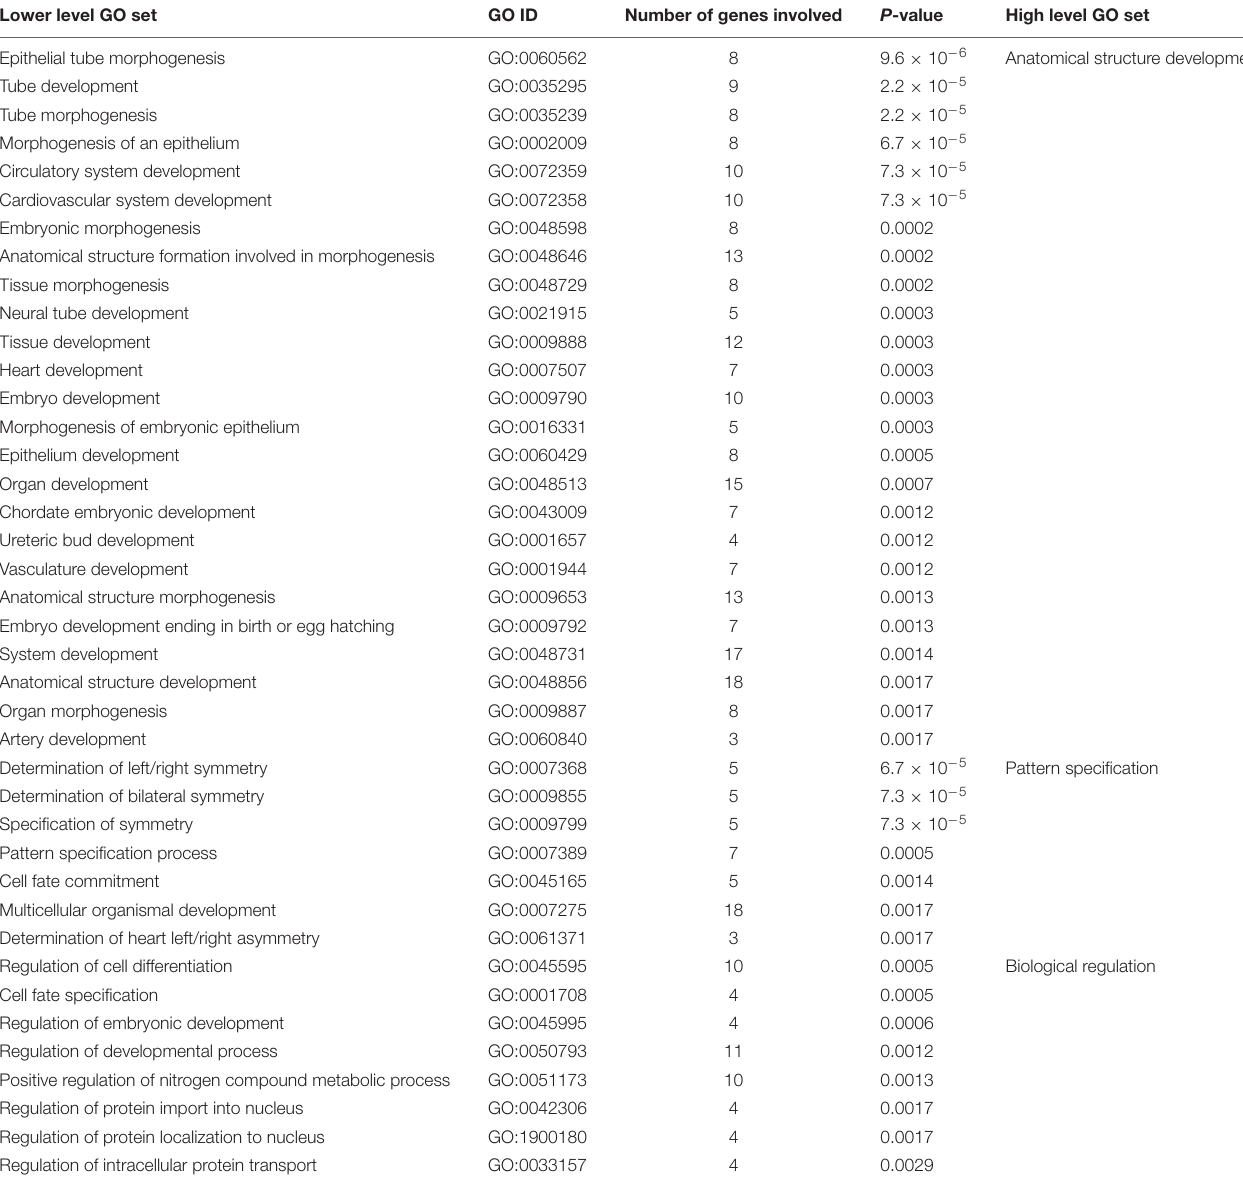
TABLE 3 | Lower level and high level gene ontology (GO) sets enriched in genes associated with handedness ontogenesis. Lower level GO set GO